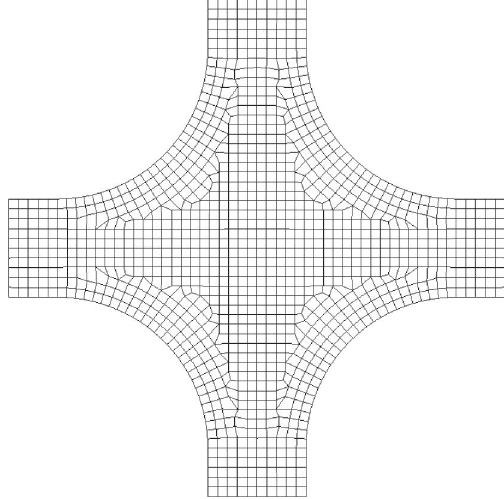
Figure 2: Cross-section view of grid level 2.